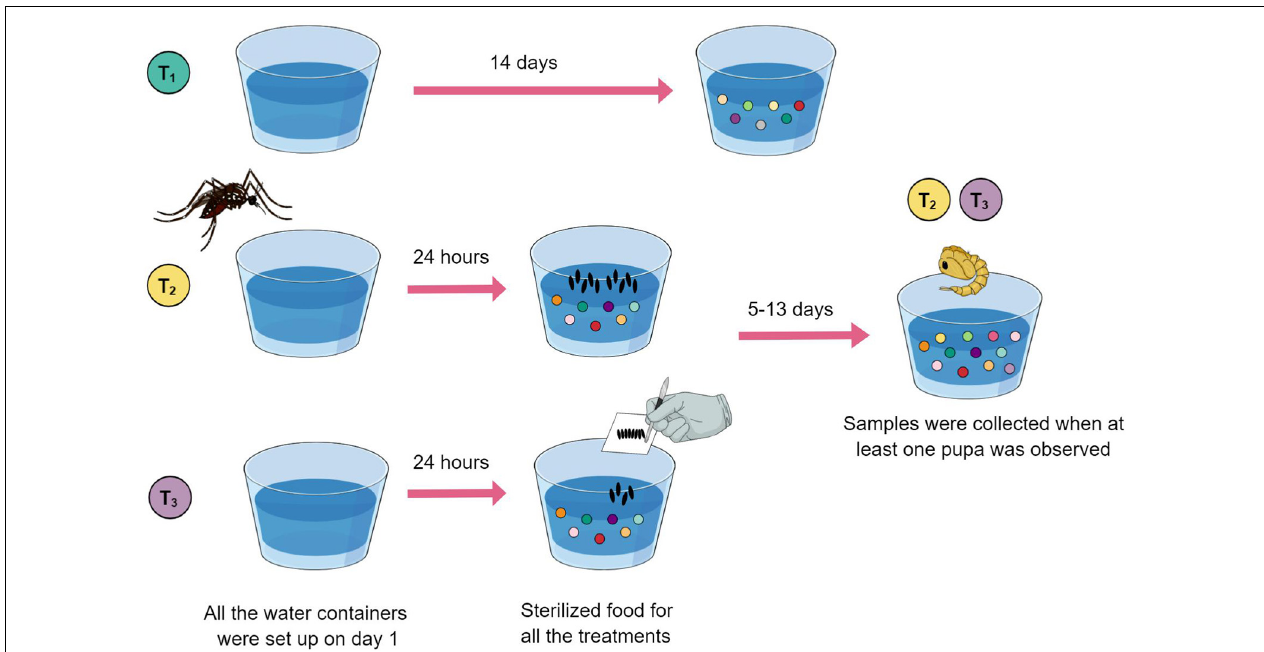
FIGURE 1 | Eleven breeding sites and five controls were set up using a plastic cup filled with type I water (day 1) plus sterilized food solution (day 2). Treatment 1 (green) cups served as experimental controls. Treatment 2 (yellow) breeding sites were visited by an ovipositing female, individually. Treatment 3 (purple) breeding sites were set up with manually deposited eggs. Controls were collected on day 14. Breeding site water samples that had larvae developing were collected when at least one pupa was